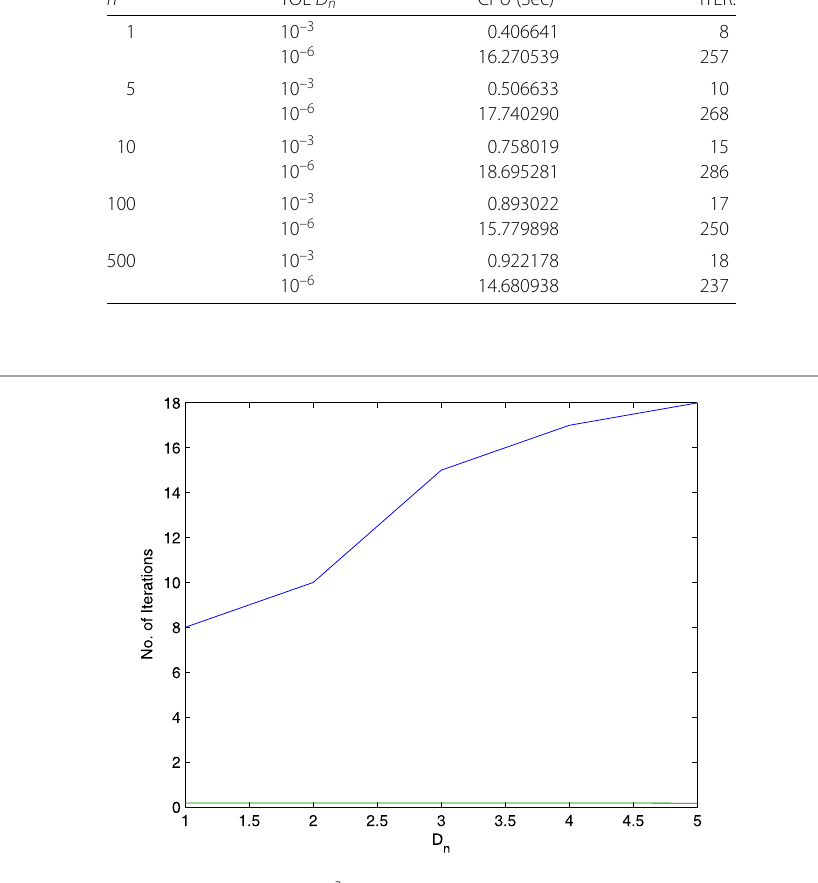
Figure 1 Comparison with tolerance of 10